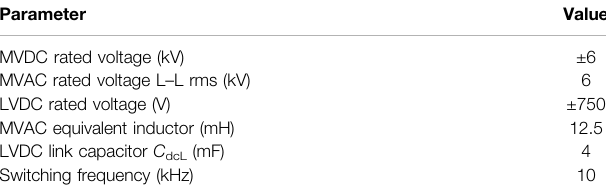
TABLE 1 | Parameters of the Simulated I-M 2 C system. Parameter